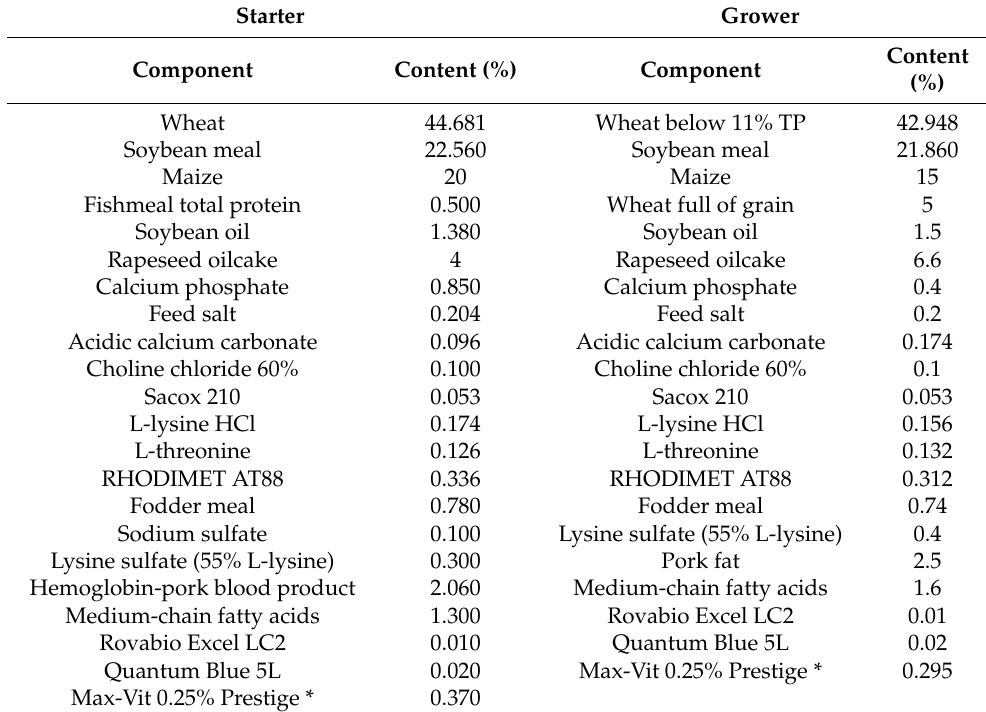
Table 1. Share of individual feed components in the basal starter and grower mix.